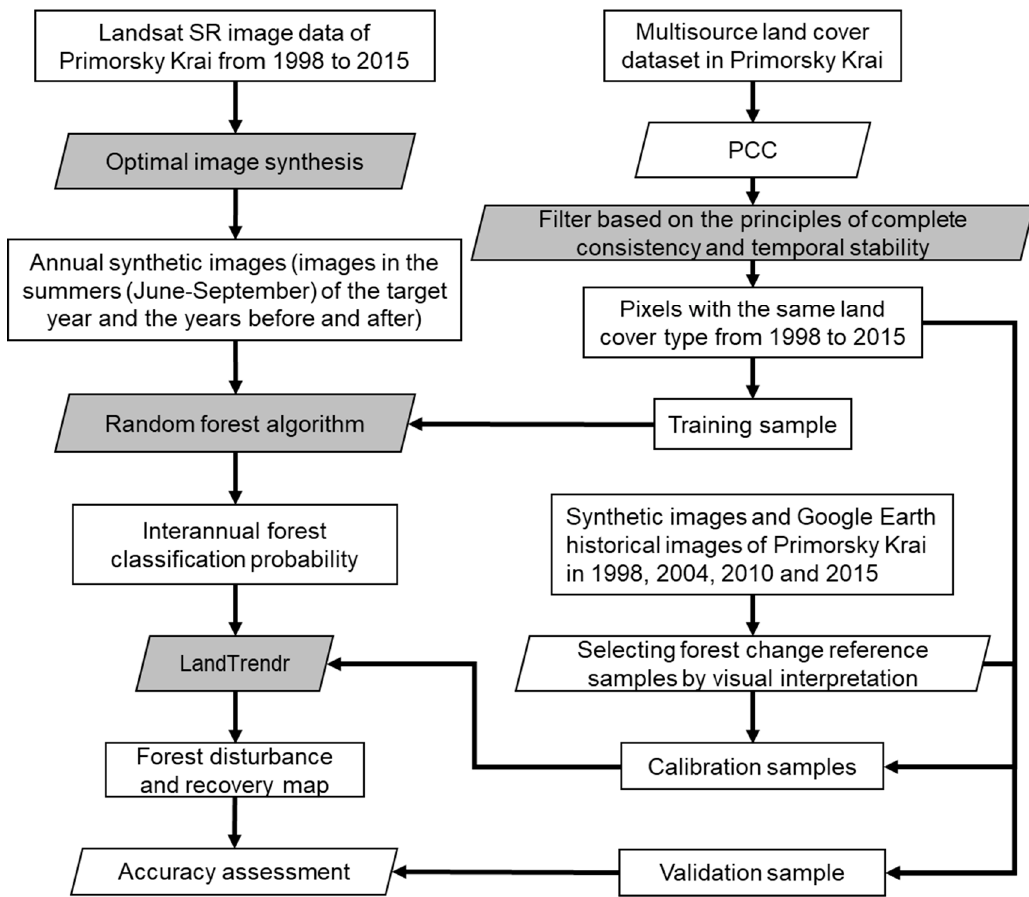
Figure 2. Overall technical process. Forest change detection consists of four key steps (the gray background boxes in the flow chart): optimal image synthesis, filtering the training sample based on the principles of complete consistency and temporal stability, using the random forest algorithm to classify the yearly images, and using LandTrendr algorithm to perform time–series segmentation. PCC means postclassification comparison.